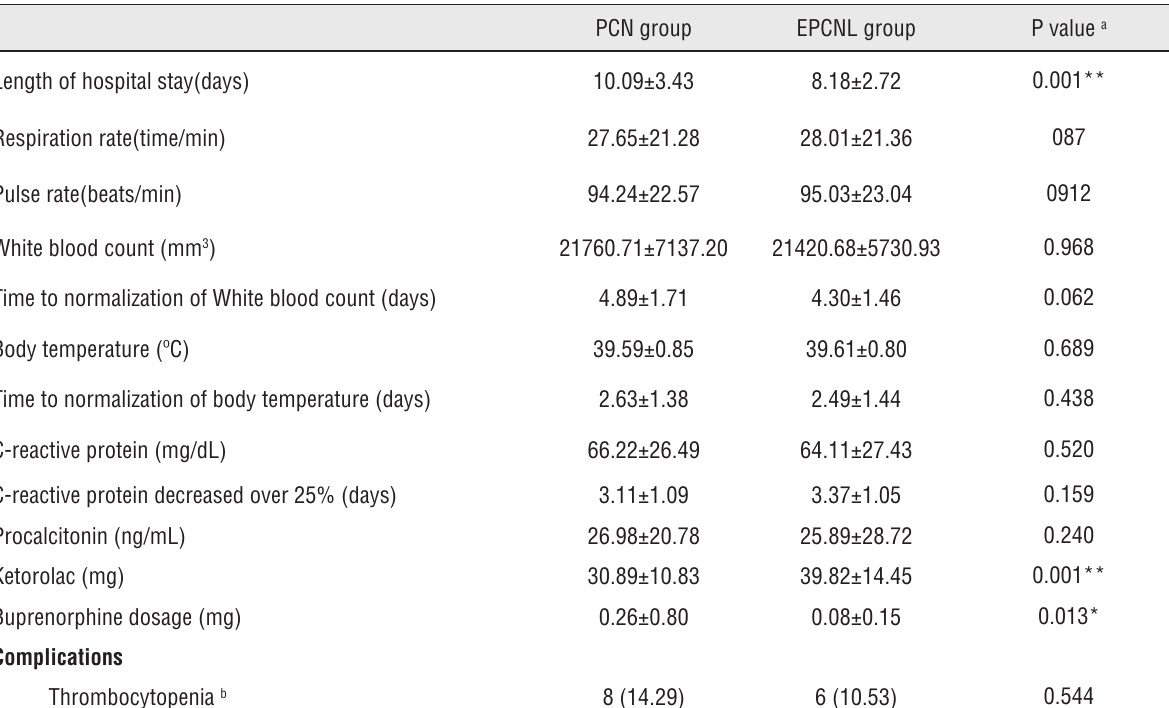
Table 2 - surgical Results and